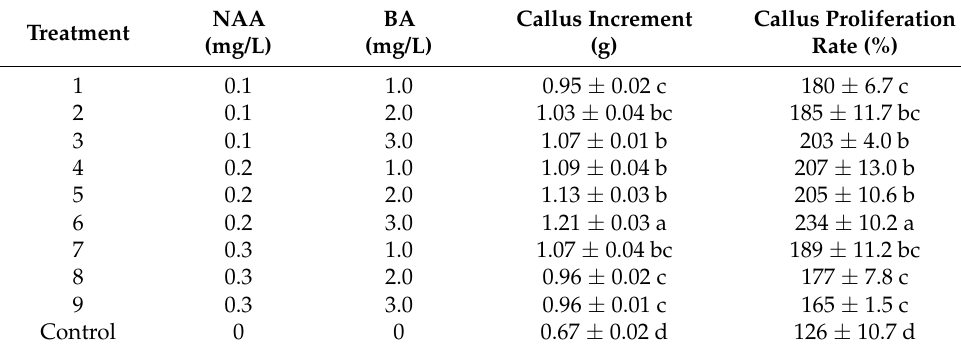
Table 2. Effects of different concentrations of growth regulators on callus proliferation 30 days after being transferred to the proliferation medium.